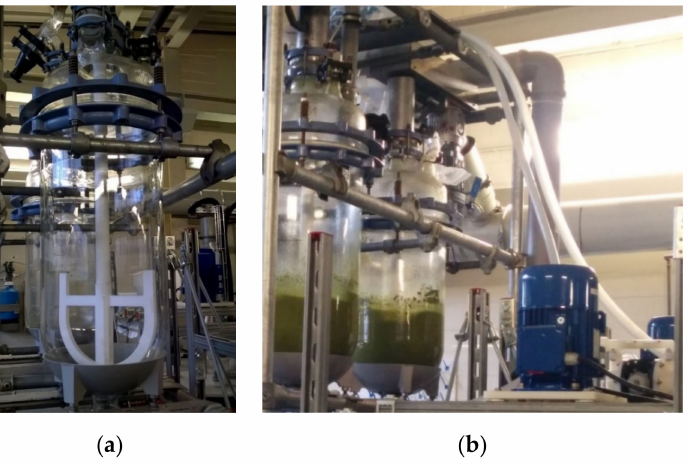
Figure 5. ( a ) Acid digestion reactor and ( b ) system of two digestion reactor during operations (key elements: anchor stirrer, glass reactor (40 L), engine, an injected tube for a transport of suspension supported by a double membrane